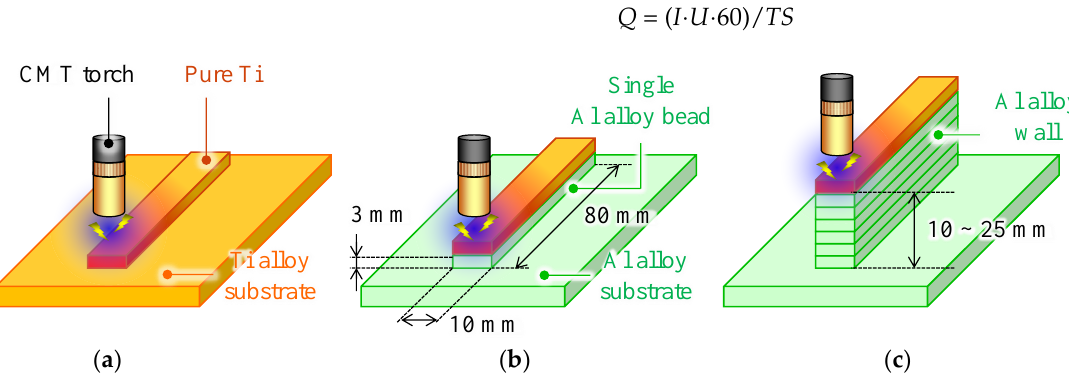
Figure 1. Schematic of deposition processes for Ti bead onto ( a ) Ti6Al4V substrate, ( b ) an Al alloy bead, and ( c ) Al wall structure.